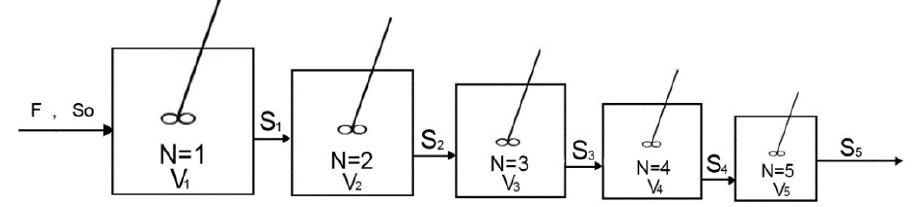
Figure 2. Typical optimum configuration of 5 CSTRs connected in series.